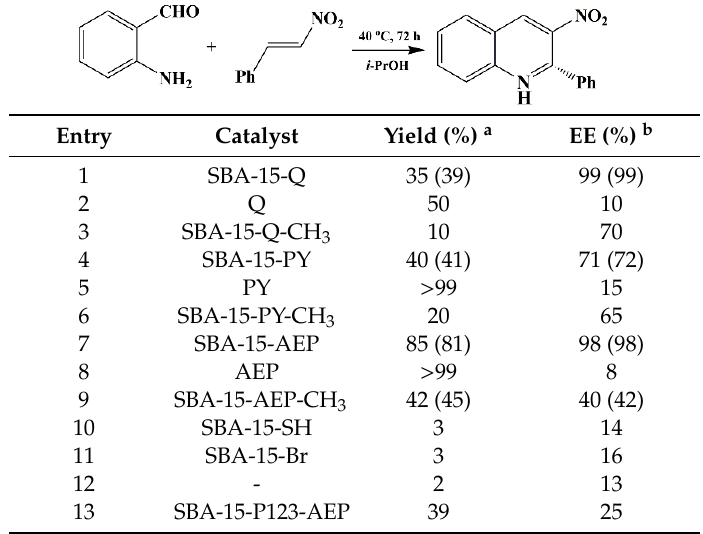
Table 2. The aza-Michael–Henry cascade reaction on designed bi-functional catalysts in i-PrOH at 40 ◦ C for 72 h.